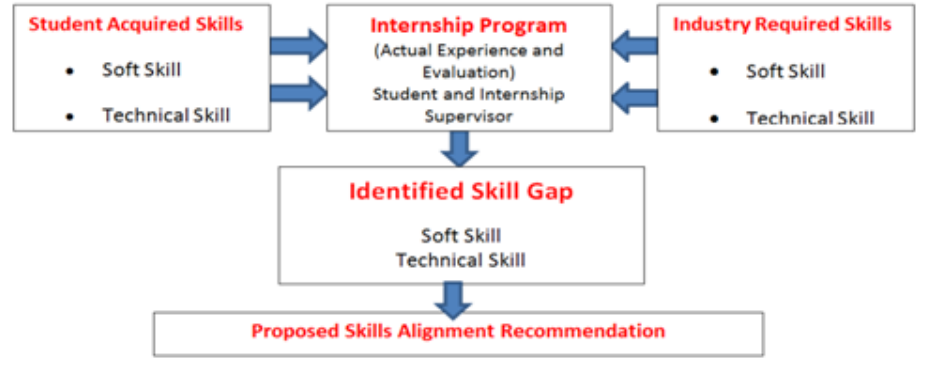
Figure 2. The conceptual framework of the